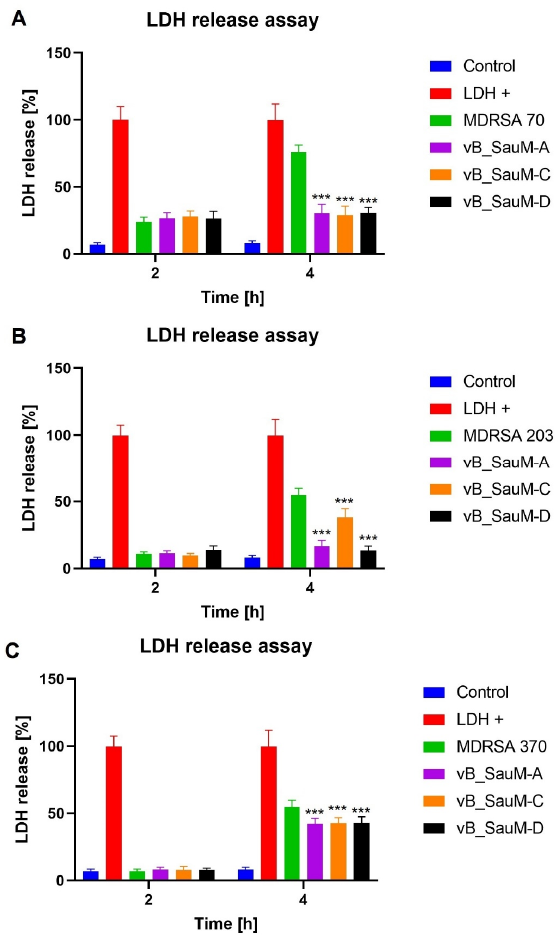
Figure 6. LDH release assay from BJ cells infected with MDRSA strains 70 ( A ), 203 ( B ) and 370 ( C ) treated with phages vB_SauM-A, vB_SauM-C and vB_SauM-D after 2 and 4 h of incubation in comparison to the phage-untreated control (green). Negative control (blue) and 10% DMSO-treated positive control (red) are visualized as referent values. Mean values from three independent experiments are shown, with error bars representing SD. Statistical analysis was performed using the Kruskal–Wallis test followed by Dunn’s multiple comparison test for values with nonparametric distribution, with *** p <